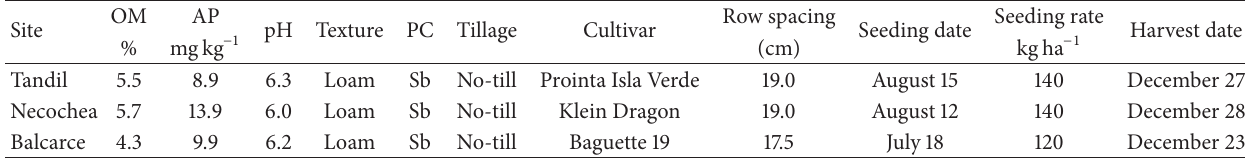
Table 1: Some characteristics of the soil surface at Tandil, Necochea, and Balcarce experimental sites. OM AP Site pH Texture PC Tillage Cultivar